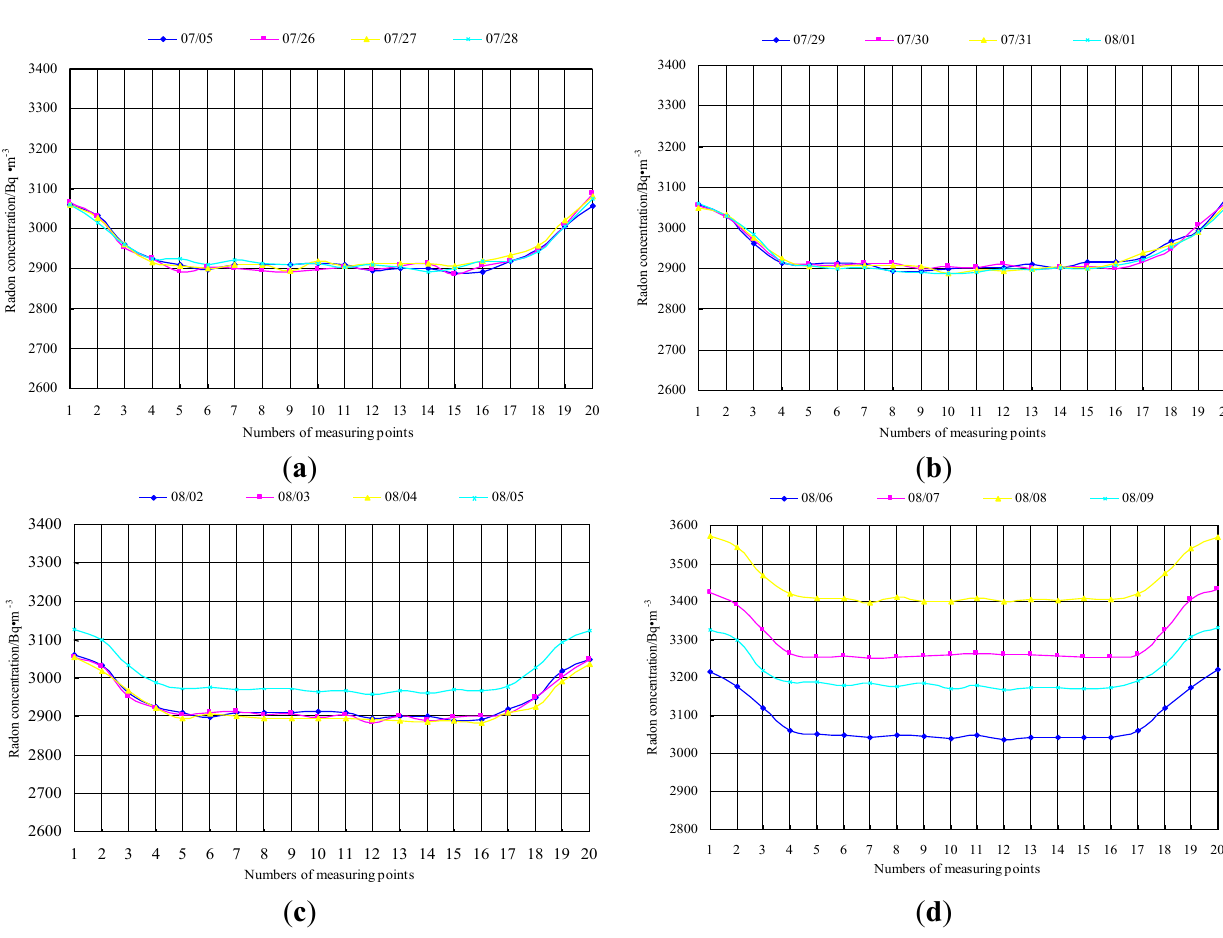
Figure 14. Variation features of the radon concentrations of ML 5: ( a ) 25 July to 28 July; ( b ) 29 July to 1 August; ( c ) 2 August to 5 August; and ( d ) 6 August to 9 August.